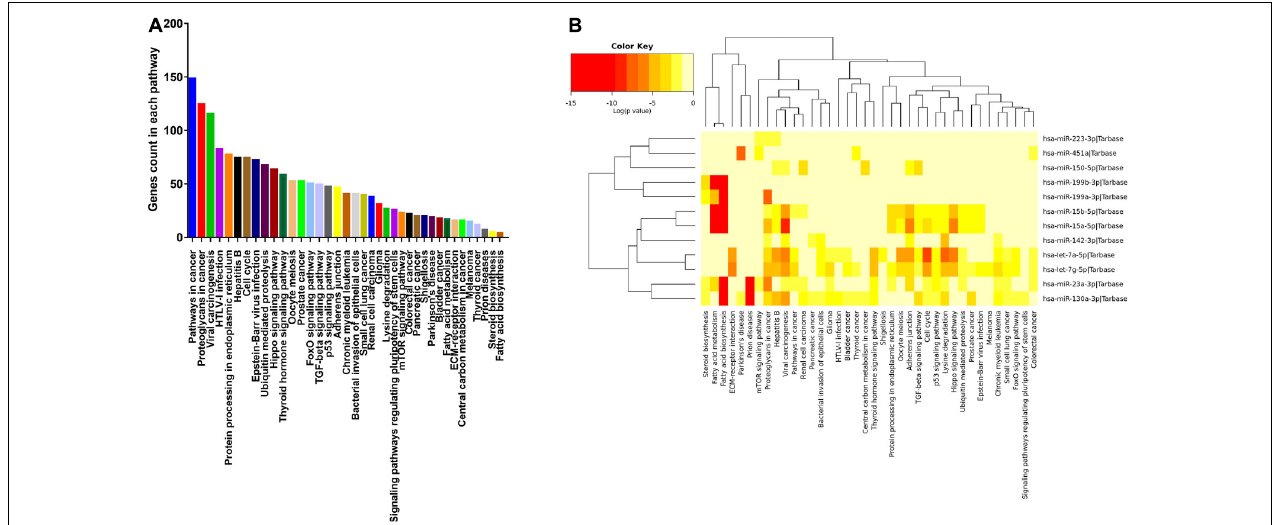
FIGURE 4 | Pathways targeted by the 12 similarly expressed exomiRs in the active young and active senior group. (A) Number of genes targeted within each pathways ranked based on high to low. (B) The 12 similarly expressed exomiRs in the active young and active senior group regulate 38 signaling pathways in total.